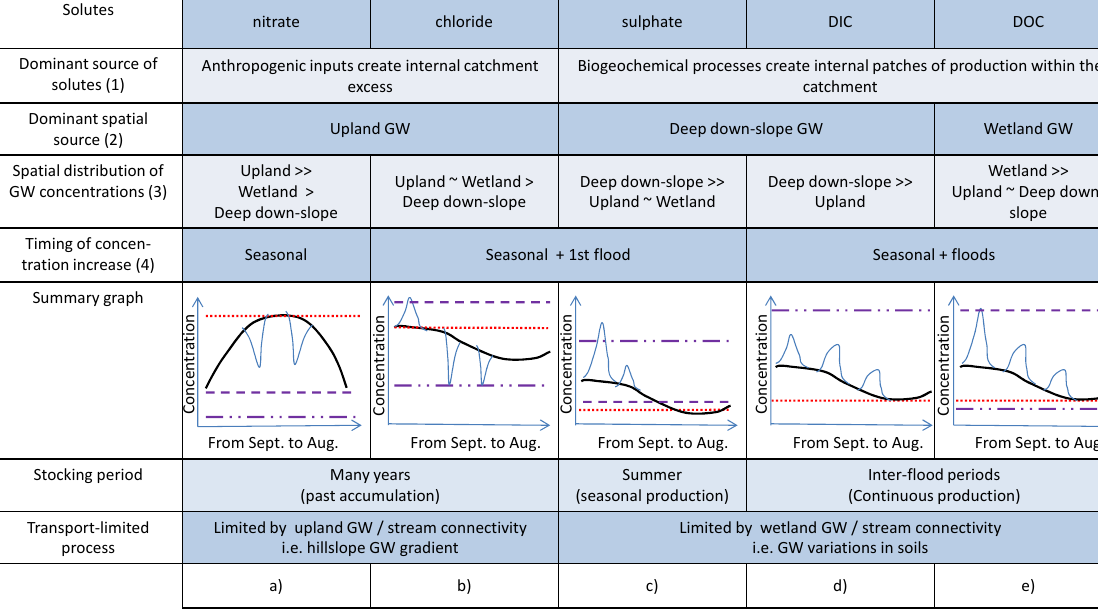
Fig. 5. Generic classification of the temporal patterns of elements and their determinants. Thick lines represent stream concentrations between floods throughout a year. Blue lines represent the reaction during a flood. Horizontal (red) dotted lines represent mean upland groundwater (GW) concentrations, while horizontal dot-dashed (purple) lines represent mean deep downslope GW concentrations and dashed (purple) lines represent mean wetland GW concentration. Criterion (1) is deduced from the bibliography. Criterion (2) is deduced from the comparison of stream concentrations to GW concentrations. Criterion (3) is deduced from the comparison of GW concentrations. Criterion (4) is deduced from the temporal patterns. For interpretation of the references to colour in this figure legend, the reader is referred to the web version of this article. can be exported. The timing, rate and duration of the con- nectivity are controlling factors of the export. Nitrate differs from chloride as nitrate production exists, even if it is not the main source, whereas chloride is not produced in the